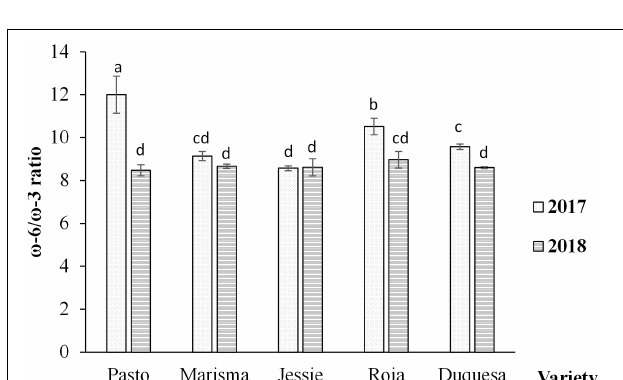
FIGURE 6 | Polyunsaturated fatty acid, MUFA, and SFA contents in quinoa seeds obtained from five varieties and 2 cultivation years (2017 and 2018). Vertical bars mean SD. Bars that do not share the same letters show statistically significant differences following an ANOVA test and Tukey’s post hoc test (SFA) and a Welch’s ANOVA test followed by a Games-Howell post hoc test (MUFA, PUFA) at a p -value < 0.05. SFA: C14:0 + C15:0 + C16:0 + C17:0 + C18:0 + C20:0 + C22:0. MUFA: C16:1 + C17:1 + C18:1 + C20:1 + C22:1. PUFA: C18:2 + C18:3.